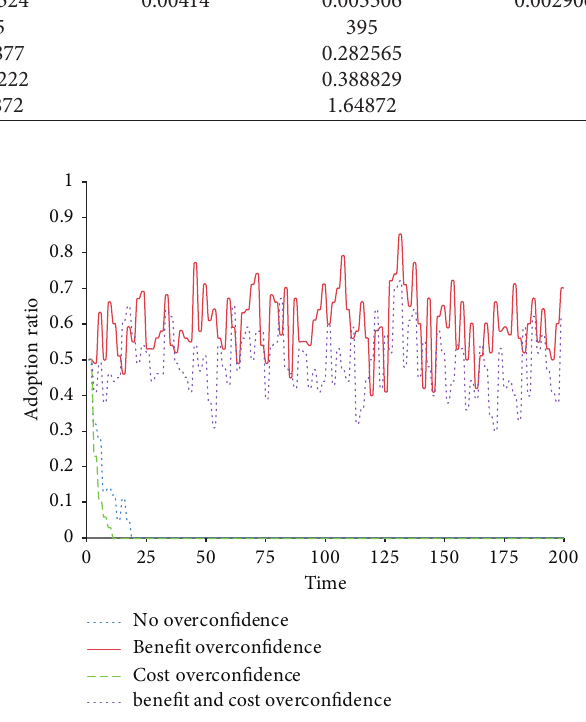
Figure 13: Effect of different scenario models on product diffusion.